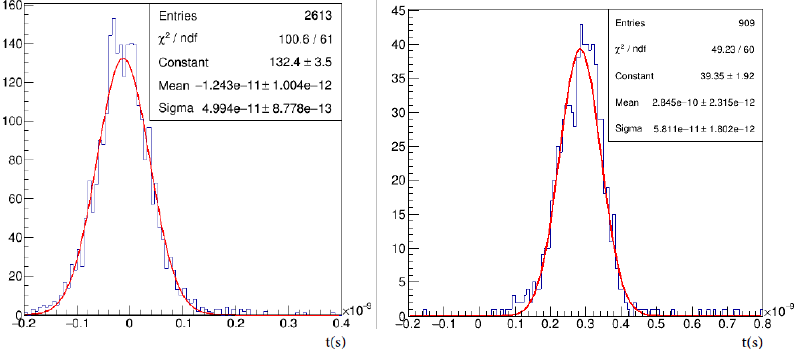
Figure 5. Distribution of ∆ t in the configuration with two LGADs at − 20 °C ( left ). Distribution of ∆ t in the configuration 3D-LGAD ( right ) with the 3D detector irradiated at a fluence of 1.0 × 10 16 n eq , at a temperature of − 20 °C for a bias voltage of 150 V. Table 2. Time difference between two LGADs in coincidence. Temp.